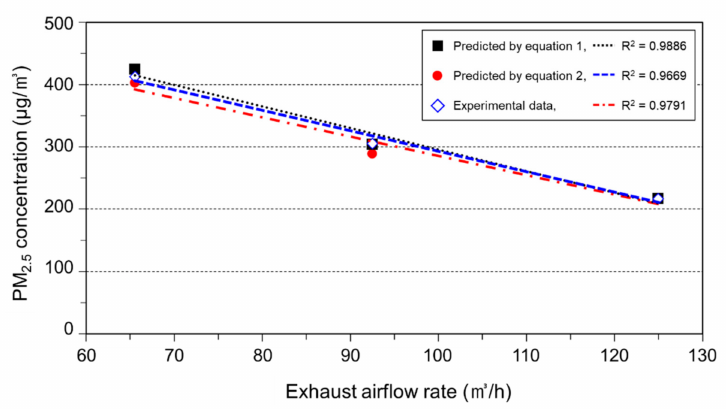
Figure 5. Comparison of experimental data and predicted